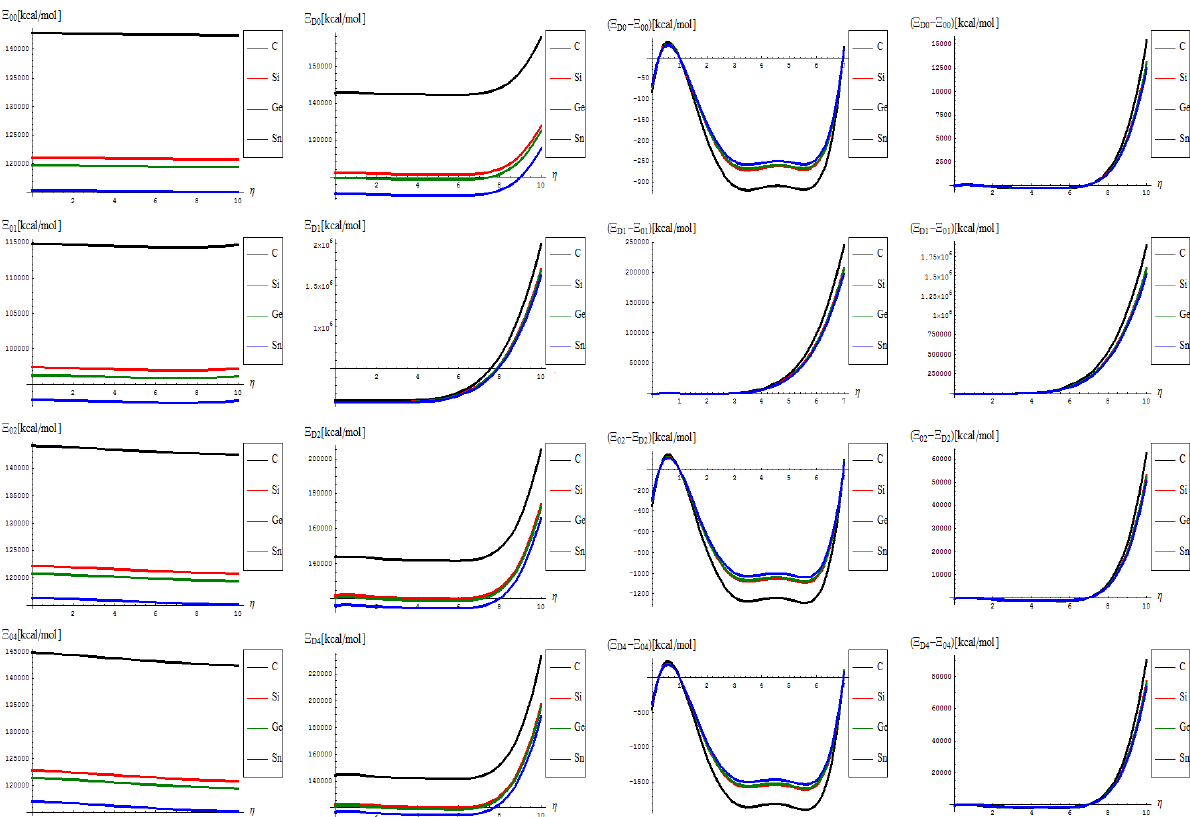
Figure 3. The Wiener based topological potentials of Equations (27)–(34): from top to bottom in successive orders and from left to right for the forming (“0”) SW and for propagating (“D”) of the SW defects on the medium ( η = 0–7) and long range ( η = 0–10) range,